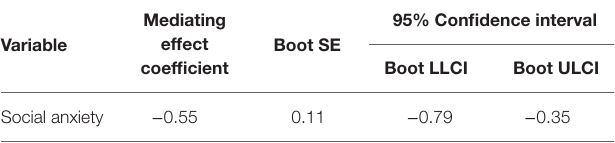
TABLE 3 | Bootstrapping results for the mediating effect of social